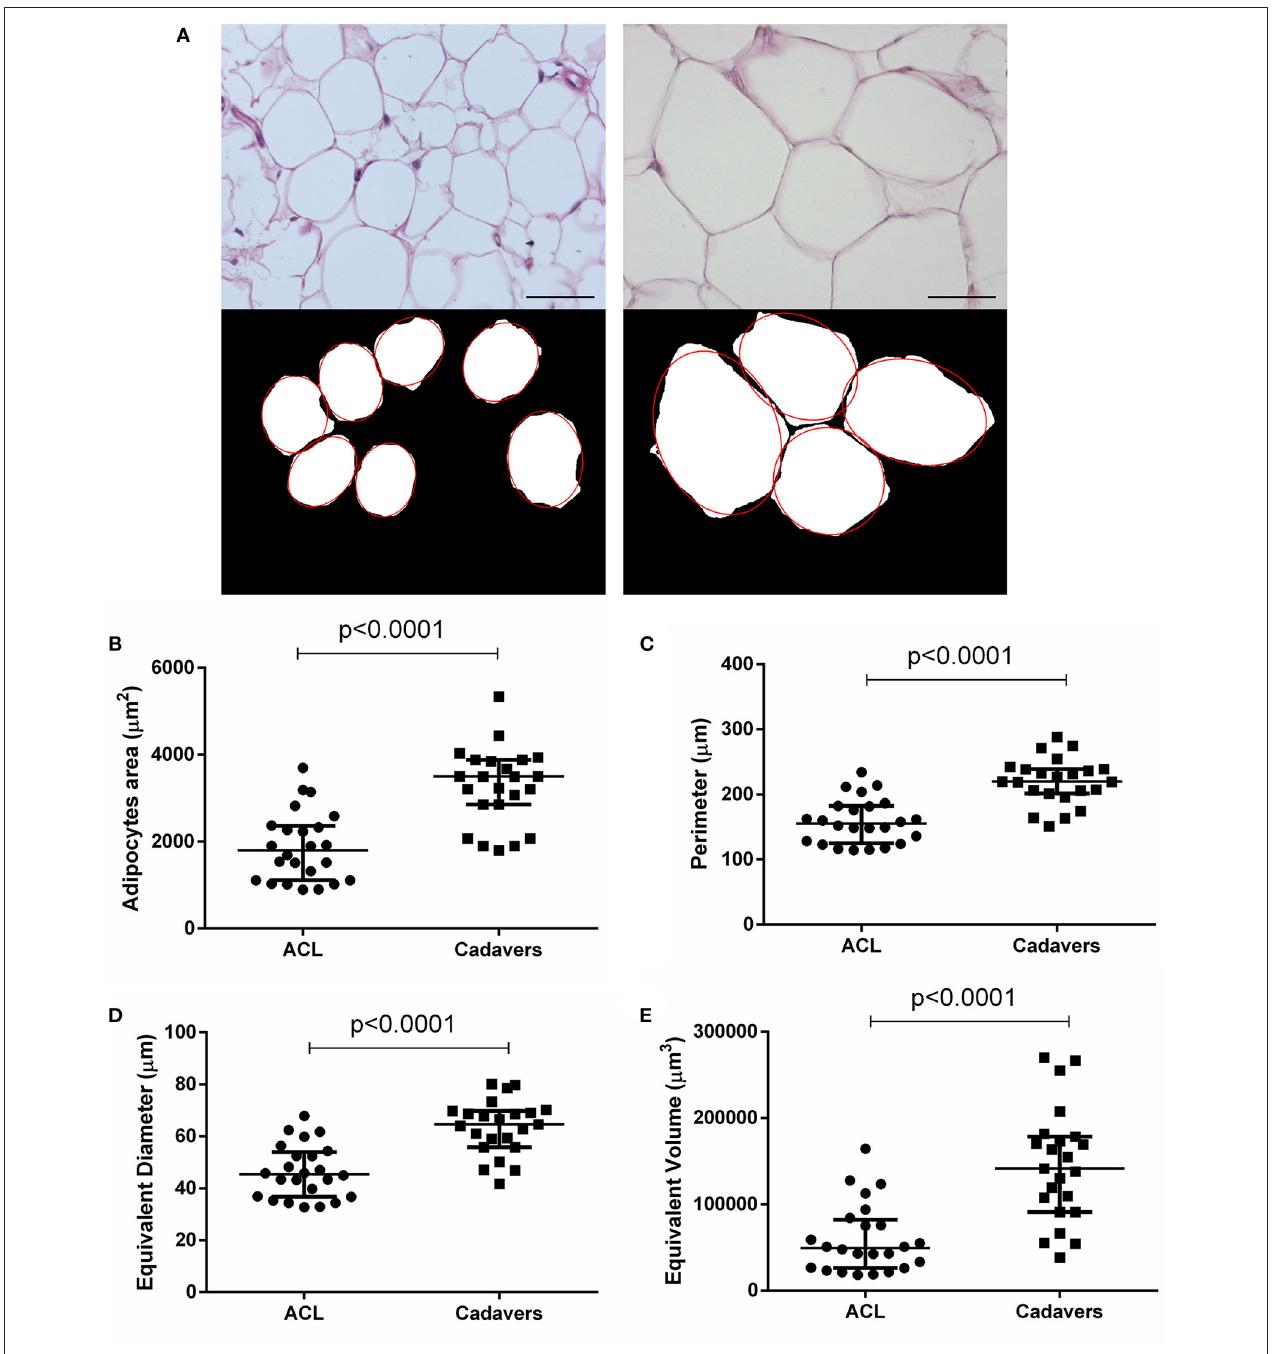
FIGURE 2 | Adipocytes morphometric analysis. (A) After H&E staining of ACL-IFPs (scale bar = 100 µ m) and cadaver donor-IFPs (scale bar = 200 µ m), the images were processed. The adipocytes were manually identified (see the red-line profile); thus, the images were converted into the corresponding 8-bit gray-level images for the measurements of mean adipocytes area ( µ m 2 ). As showed in the graphs, a significant difference ( p < 0.0001) was detected between the two experimental groups for the adipocytes area (B) but also for the adipocytes perimeter (C) , equivalent diameter (D) and equivalent volume (E) ; ACL-IFPs samples n = 24 and cadaver donors-IFPs n = 23 samples. Data are reported as the median and interquartile range (IQR).